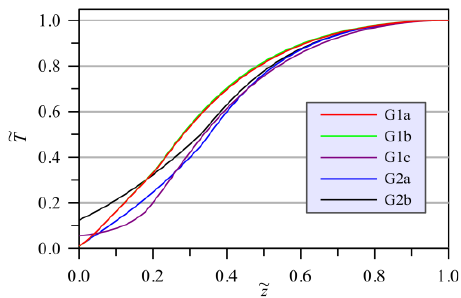
Figure 10. Vertical temperature profiles of WC/SiC MLLs of different geometries at the end of 20